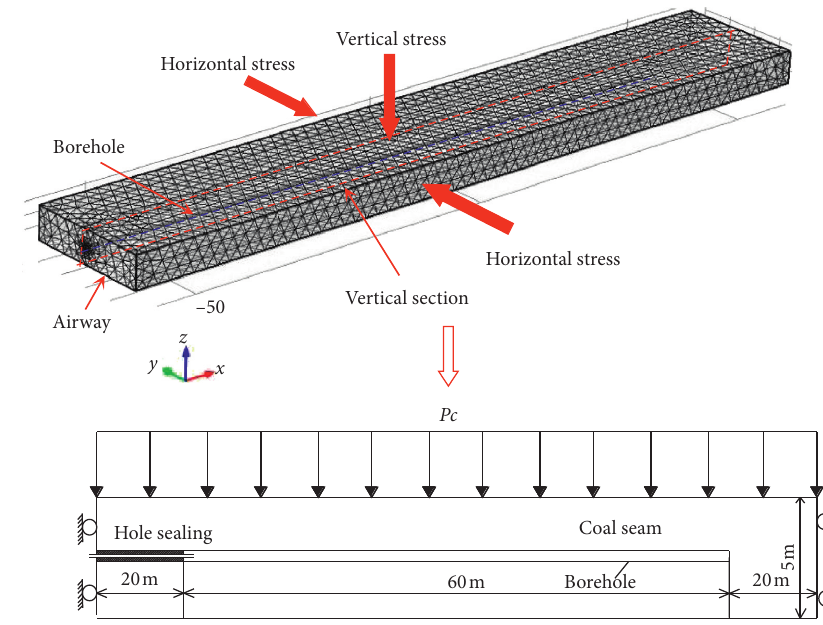
Figure 4: Map of three-dimensional geometrical modeling. Table 1: Simulation parameters.